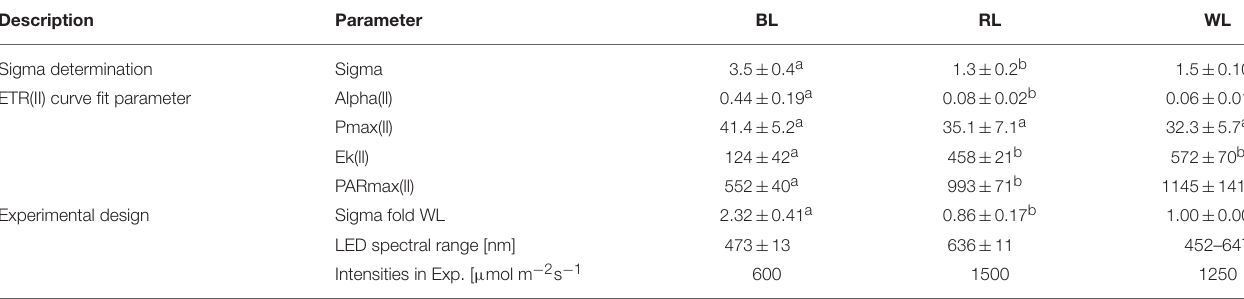
TABLE 1 | Photosynthetic characteristics of Coscinodiscus granii incubated under blue (BL), red (RL), and white (WL) light.